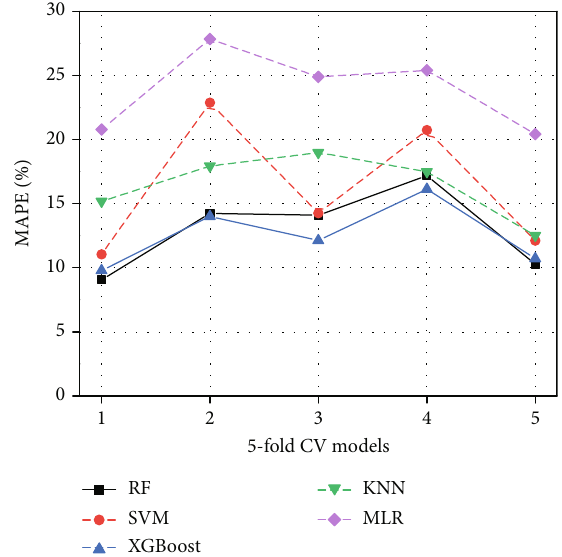
Figure 8: RMSE results of the 5-fold cross-validation.